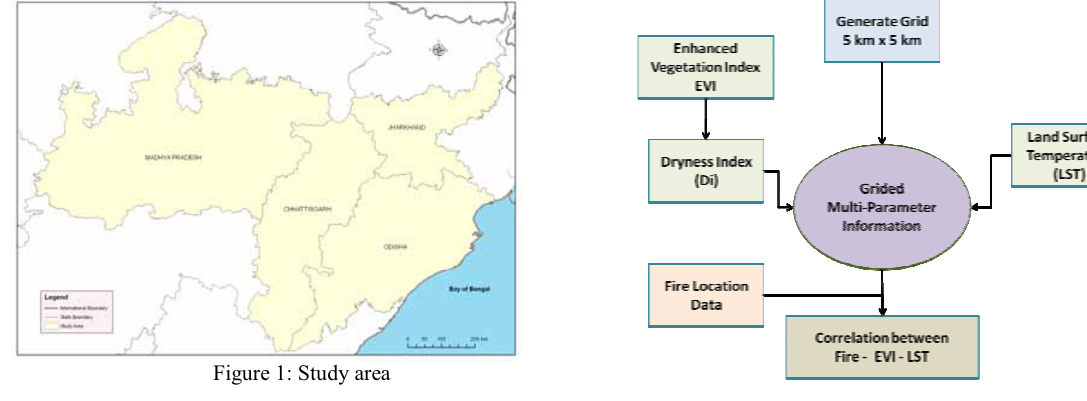
Figure 2: Flow chart showing the multi-parameter analysis 2.3.4 Forest fire patterns in various phenological and vegetational regimes: Various vegetations across the forest landscape reveals different patterns of gradual phenological changes which are directly attributed to change in